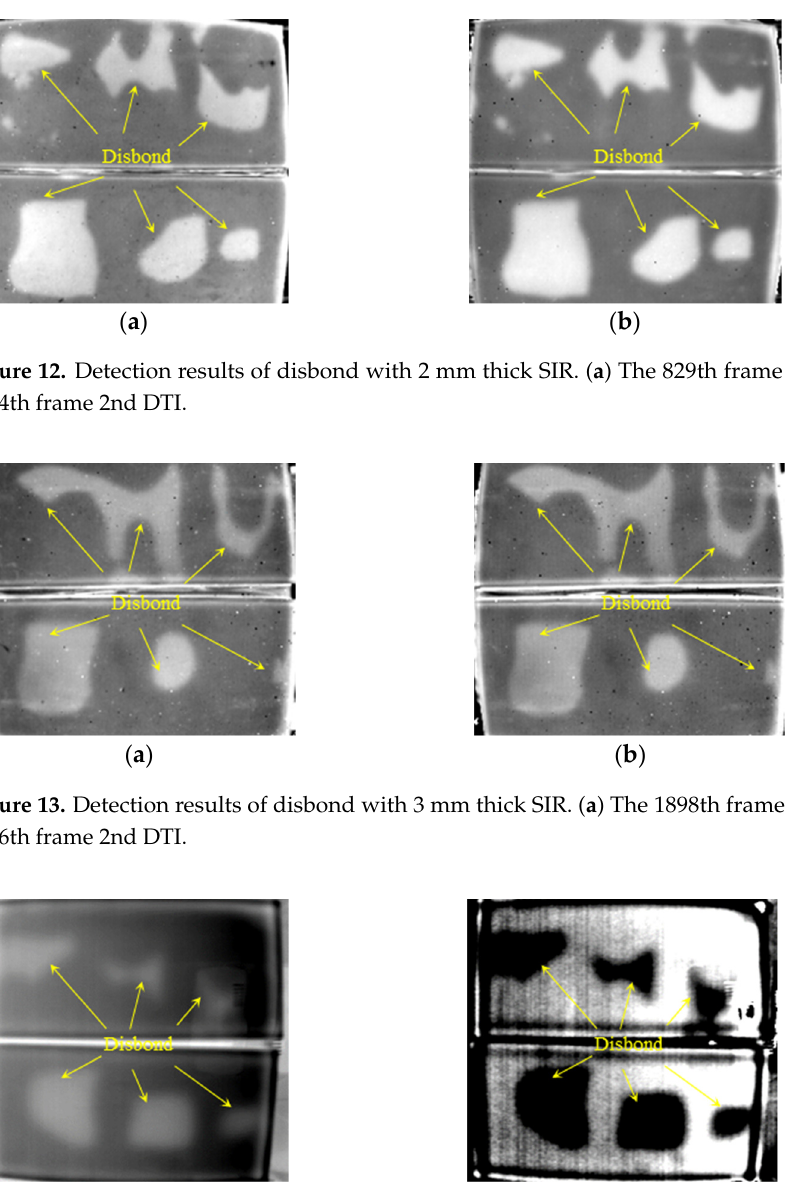
Figure 14. Detection results of disbond with 5 mm thick SIR. ( a ) The 2117th frame 1st DTI. ( b ) The 3476th frame 2nd DTI.